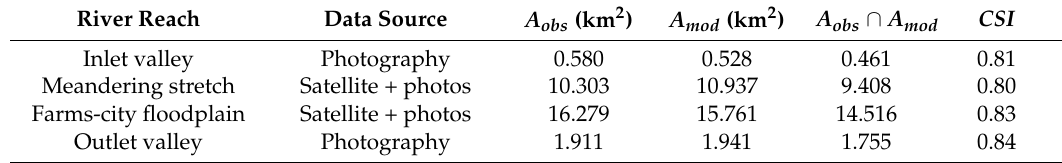
Table 4. Comparison of inundation extents from model simulation and remote sensing data.